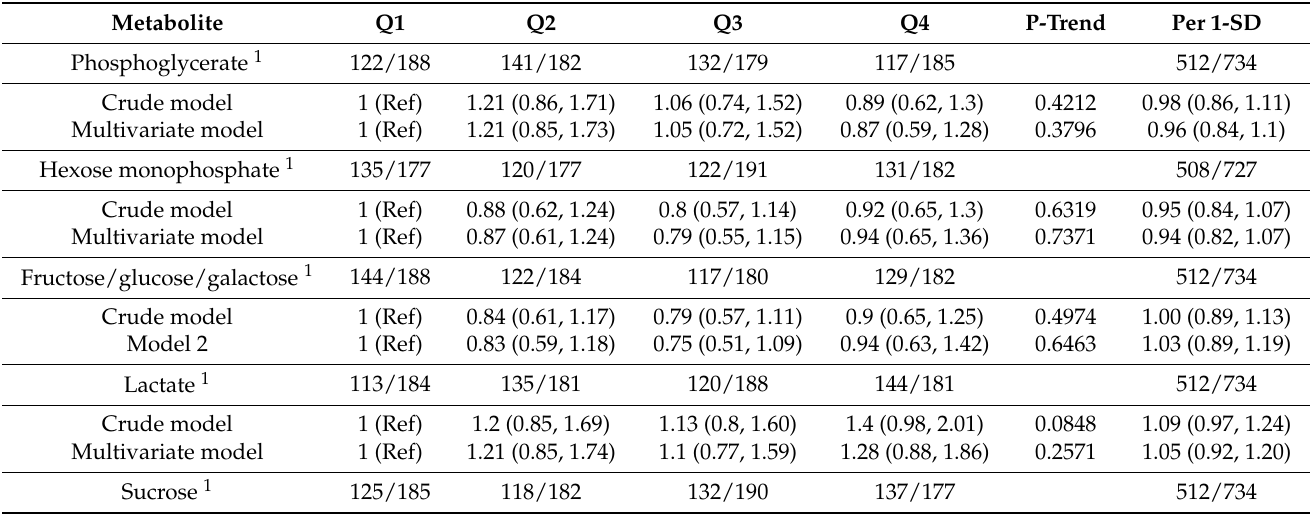
Table 2. Association between baseline plasma glycolysis species or other related metabolites and incident atrial